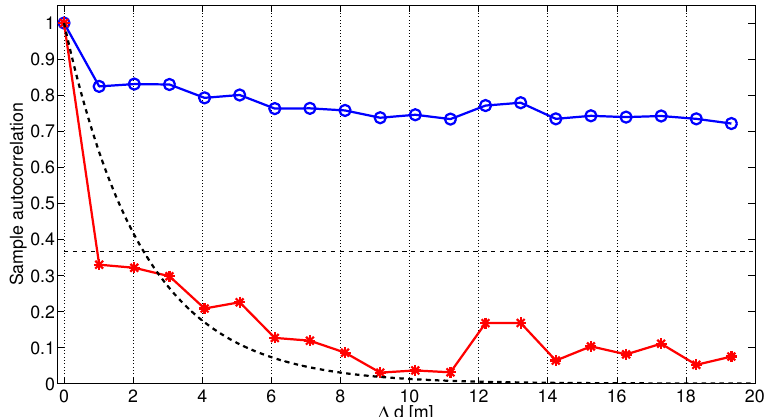
Figure 10. Auto-correlation function for the large scale fading, for both measurements and the model according to (4) of the communication link between XC90 Black Front and Truck Gold Right at intersection Yngve. Two measurement curves are seen in the figure: (1) where the large scale fading processes in this link are non-zero-mean process (blue with circle). (2) where the offset values have been subtracted from the large scale fading processes, i.e., a zero-mean process is achieved (red with stars).